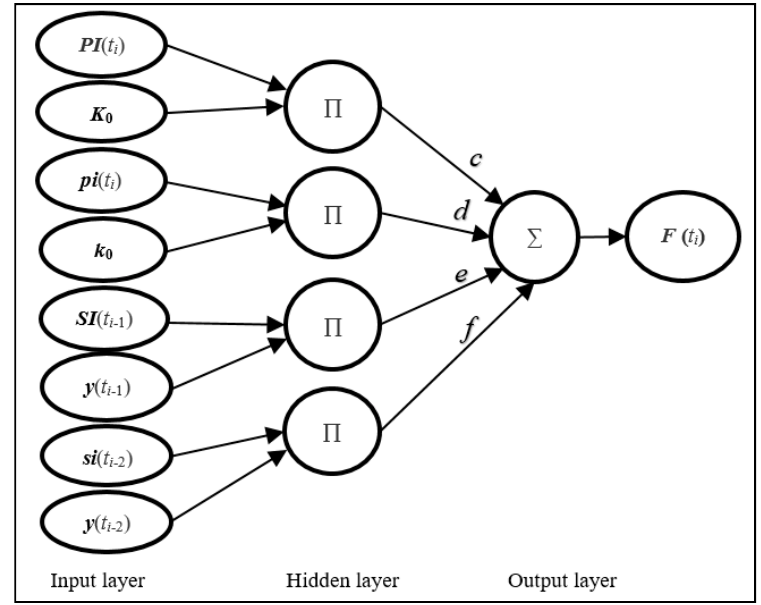
Figure 2. The architecture of the period-sequential index algorithm with sigma-pi neural network (SPNN-PSI).